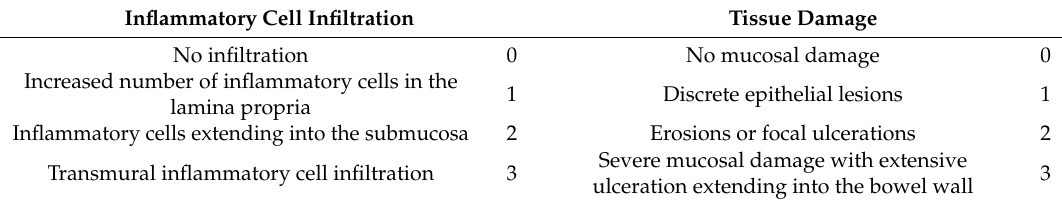
Table 3. Evaluation of histological